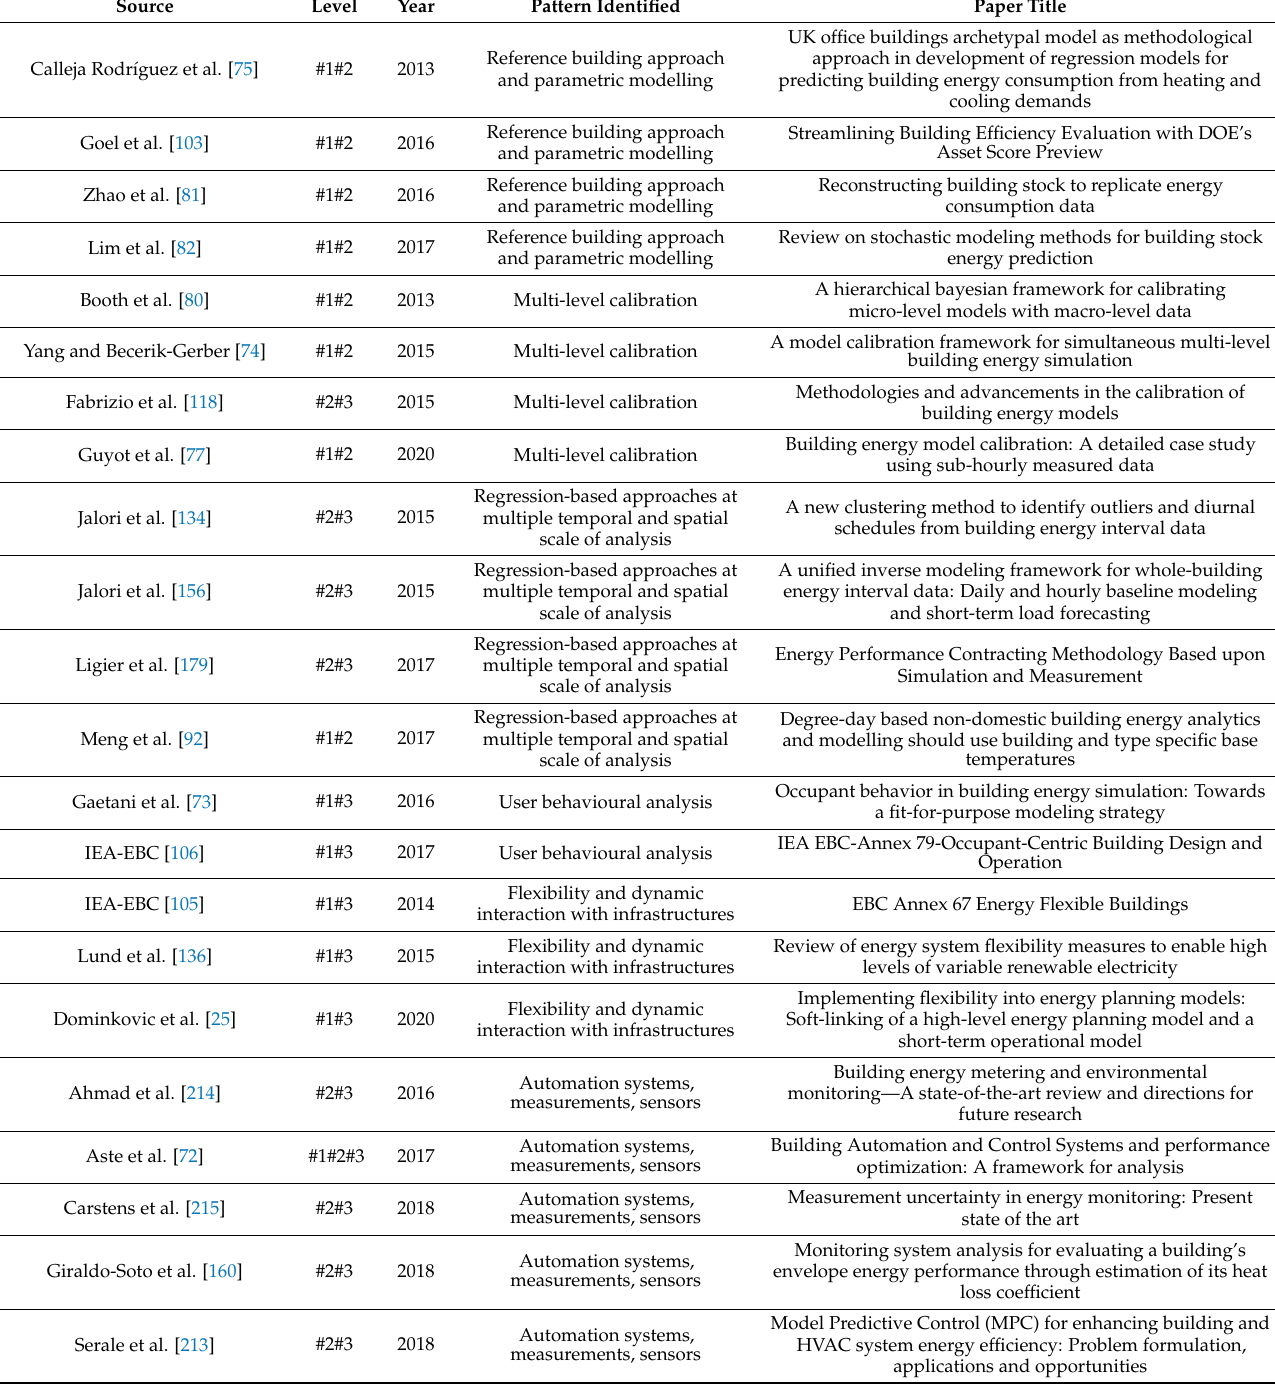
Table 7. Articles at the intersection of levels of